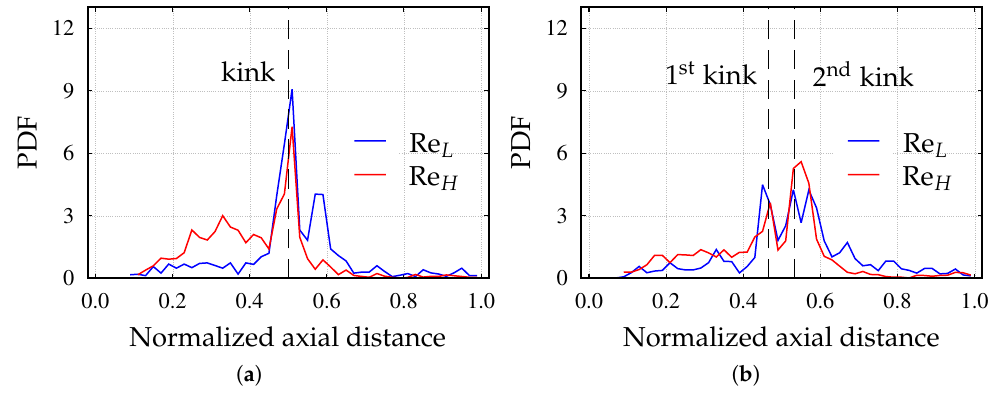
Figure 18. Positions of the wall-impact breakage event along the axis of the pipe bend. The axial distance is normalized by the total length of the pipe. ( a ) 90 ◦ pipe bend. ( b ) 45 ◦ pipe